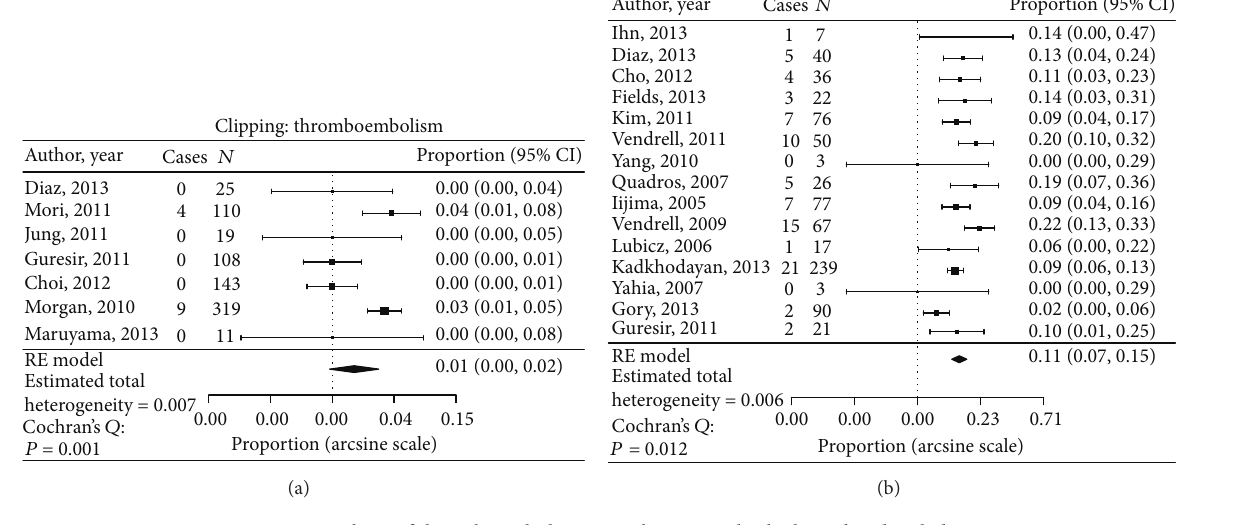
Figure 2: Data analysis of thromboembolism complication in both clipped and coiled groups.